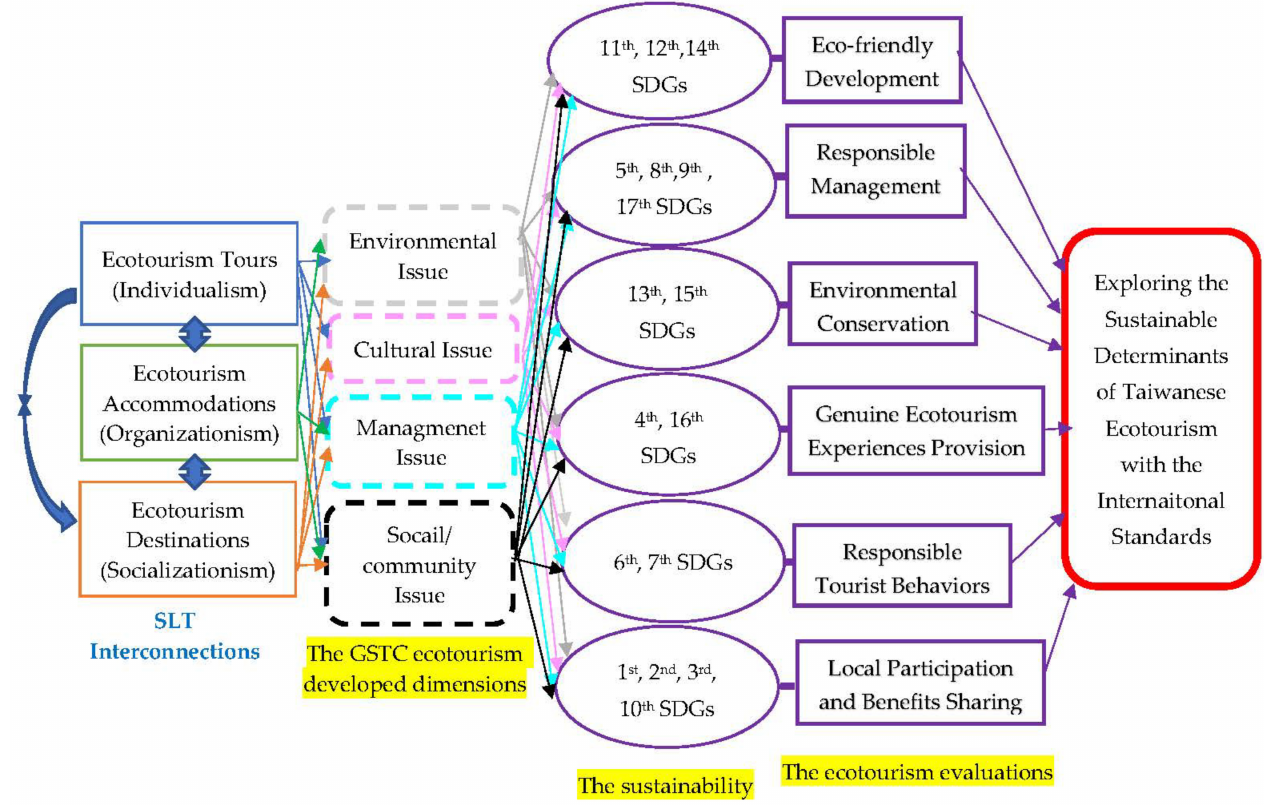
Figure 1. Main analytical concept and